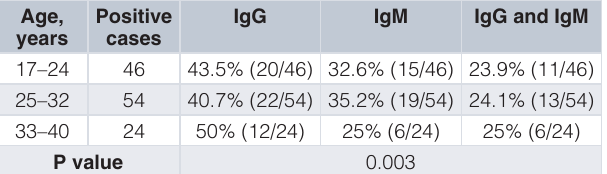
Table 1. Percentage of Toxoplasma gondii antibodies seropositivity among the total of positive cases in every age